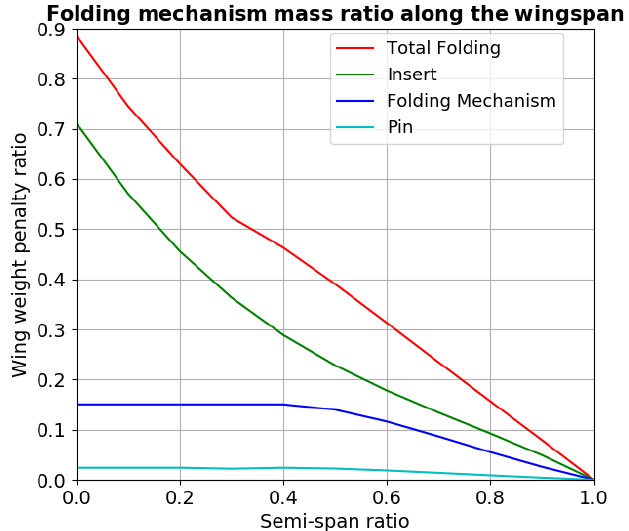
Figure 7. Wing folding penalty as a function of the wing semi-span